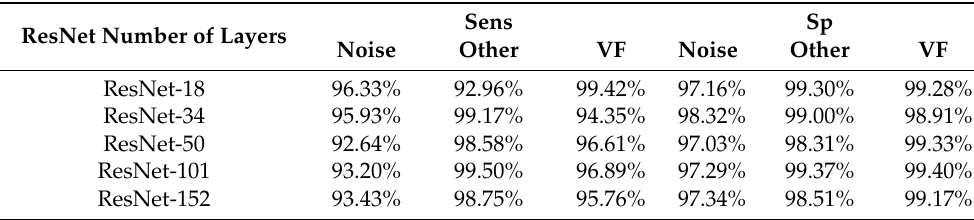
Table 5. Evaluating the first classification stage using Sens and Sp to determine the ResNet layer size. ResNet Number of